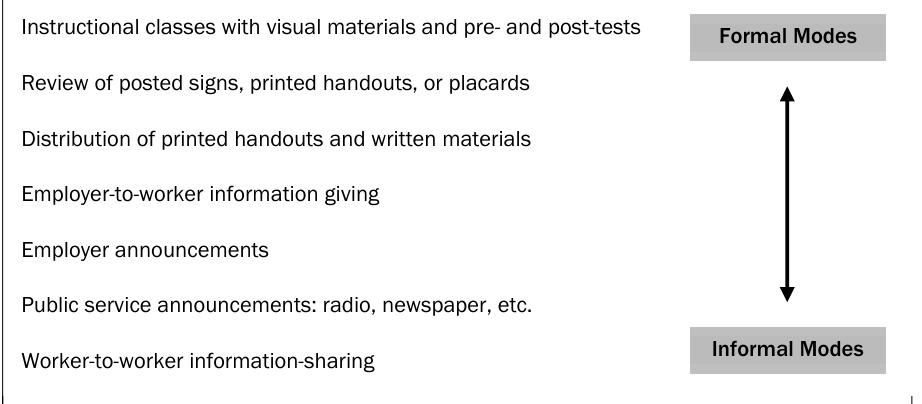
Figure 5. Modes of Worker Education and